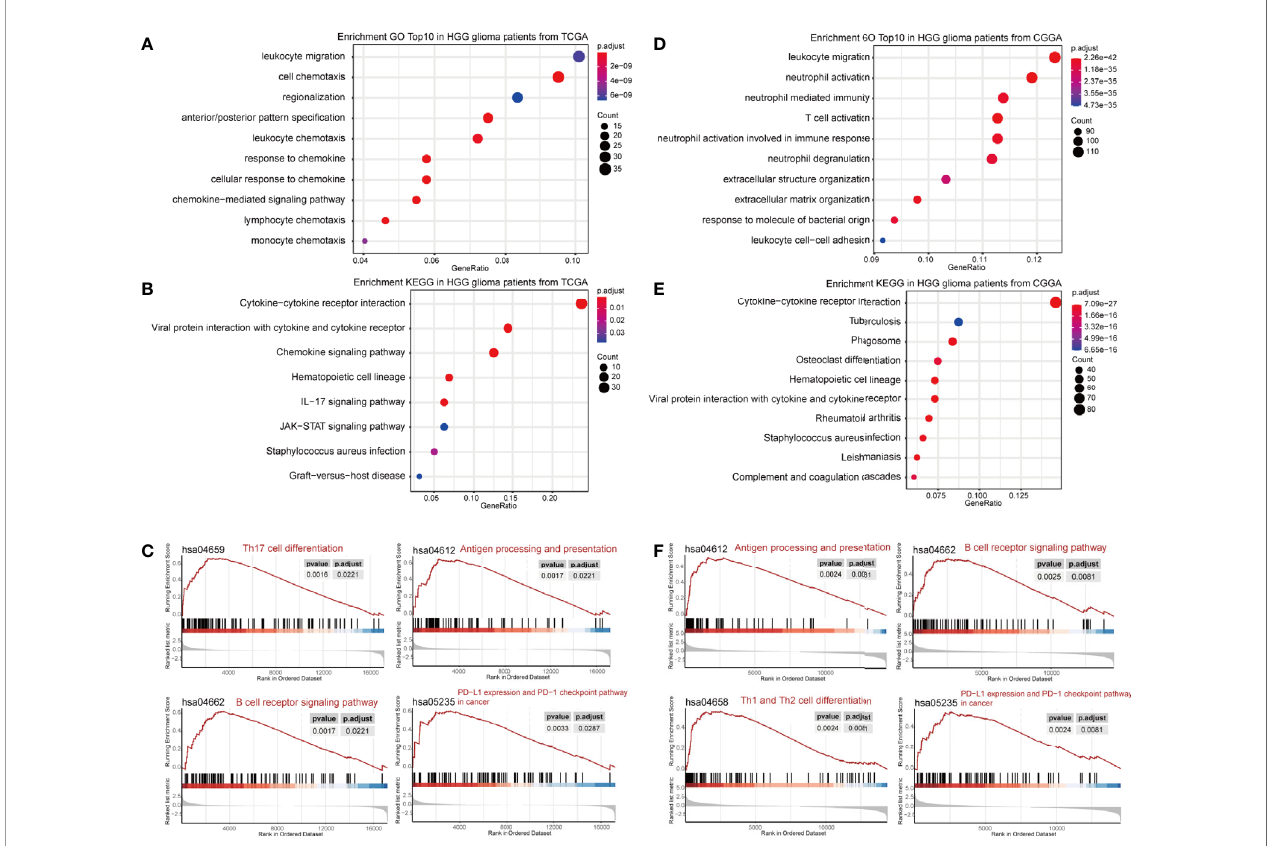
FIGURE 4 | Functional annotation of upregulated DEGs between the high- and low-GASC groups from the high-grade glioma population. (A, B) GO analysis (A) and KEGG pathway analysis (B) of up-regulated DEGs from TCGA data. (C) GSEA analysis of genes from TCGA data. (D, E) GO analysis (D) and KEGG pathway analysis (E) of up-regulated DEGs from CGGA data. (F) GSEA analysis of genes from CGGA